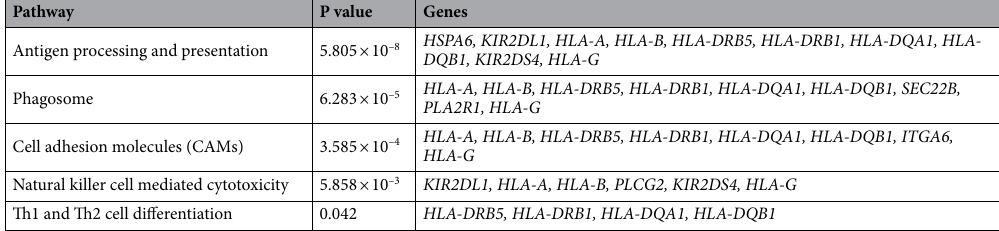
and ‘amide binding’ (P.adjusted = 3.599 × 10 –3 ), similarly seen in Table 2. Additionally, KEGG pathways of the